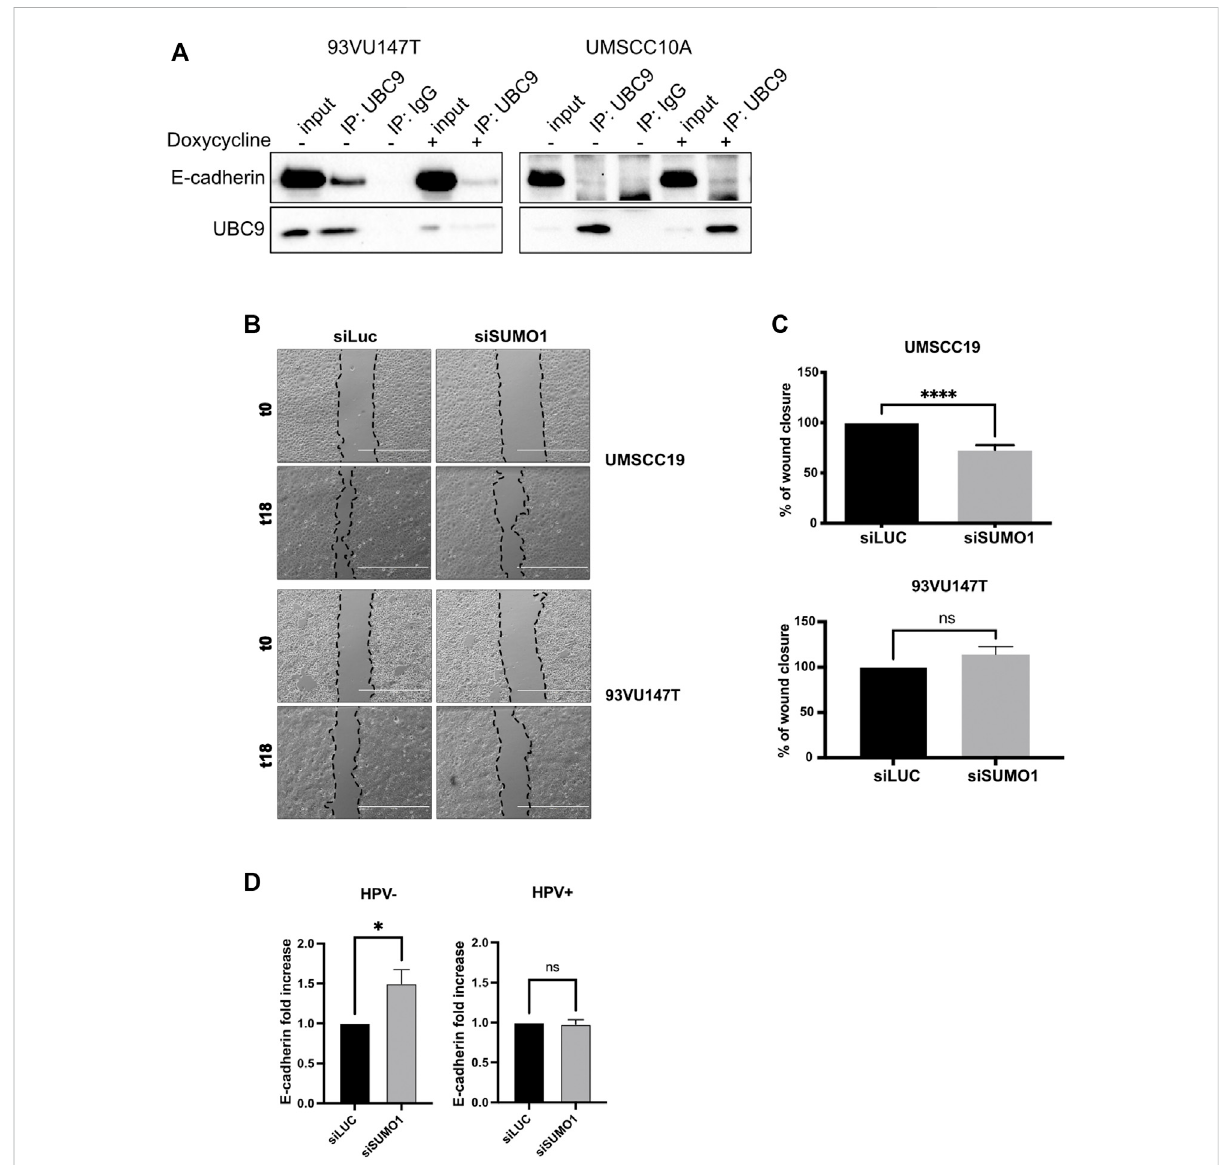
UBC9 interaction with E-cadherin and its transcriptional regulation. (A) HPV-positive 93VU147T and HPV-negative UMSCC10A cell lines were transduced with an inducible shUBC9 lentiviral vector, and treated or not with doxycycline for 72 h. Cells were then harvested and whole cell extracts were subjected to anti-UBC9 immunoprecipitation (IP). Immunoblotting with the indicated antibodies was then performed and whole cell extracts were used as input controls. (B) Phase-contrast pictures of scratch wound healing assay performed on HPV-positive 93VU147T and HPV-negative UMSCC19, transfected for 72 h with SUMO1 or LUC siRNA at time 0 and 18 h after the scratch. (C) Graph represented the percentage of wound closure (means ± SEM) of SUMO1 siRNA cells as compared with LUC siRNA transfected; ****, p < 0.0001, ns, not signi fi cant (unpaired t test). (D) HPV-positive HNC cell lines (UMSCC47, UPCISCC154, 93VU147T) and HPV-negative (UMSCC10A, UMSCC19, UMSCC23) cell lines were transfected for 72 h with speci fi c siRNA against SUMO1 or Luciferase as control. After transfection, total RNAs were isolated for RT-qPCR and reported as means ± SEM of fold changes of at least three independent experiments; *, p < 0.05, ns, not signi fi cant (unpaired t